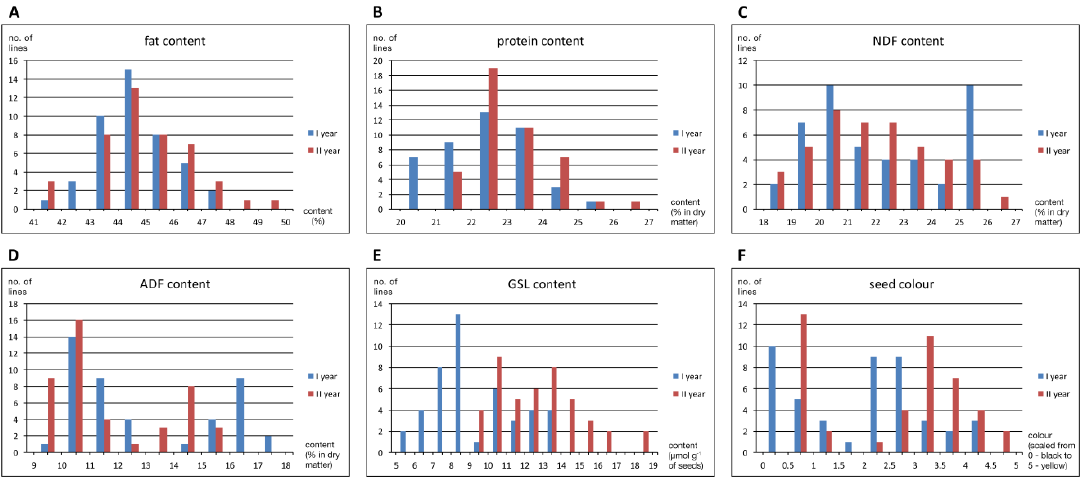
Figure 2. Frequency distribution of oilseed rape seed biochemical traits and seed colour for two years in the population of DH lines (no parental lines included). The ( A ) fat, ( B ) protein, ( C ), neutral detergent fibre — NDF ( D ) acid detergent fibre — ADF, ( E ) glucosinolates — GSL content, and ( F ) scaled seed colour values were shown. Table 3. Characteristics of trait variability in the DH population and parental